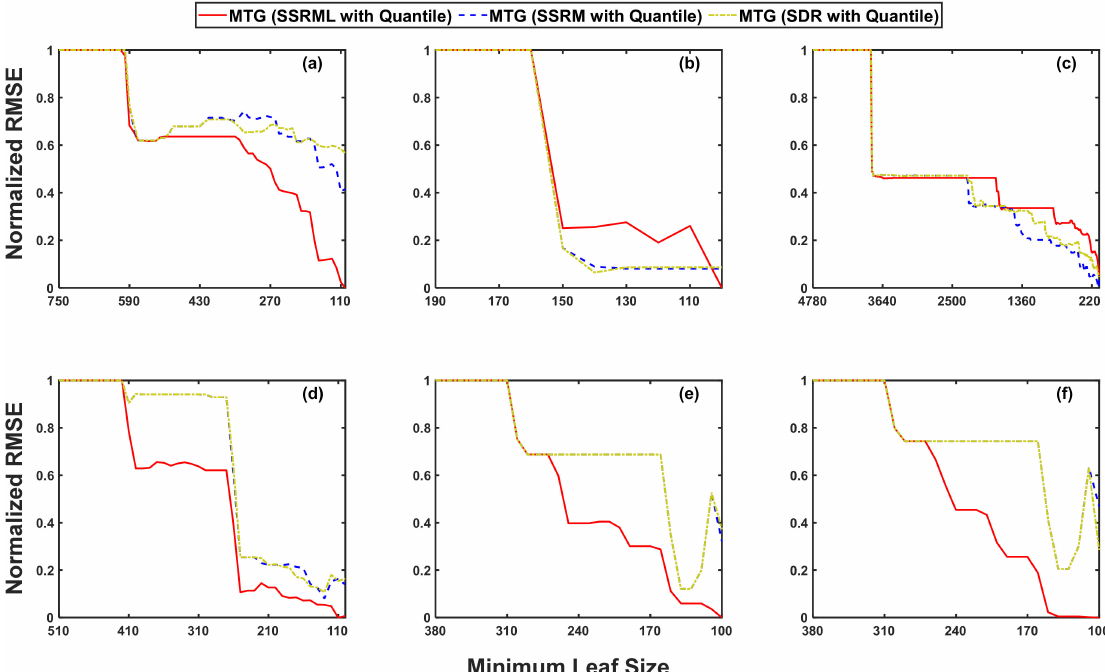
Figure 5. The normalized RMSE against minimum leaf size in descending order for ( a ) airfoil self-noise, ( b ) Auto MPG; ( c ) combined cycle power plant, ( d ) concrete compressive Strength, ( e ) Energy e ffi ciency (heating load) and ( f ) energy e ffi ciency (cooling load).